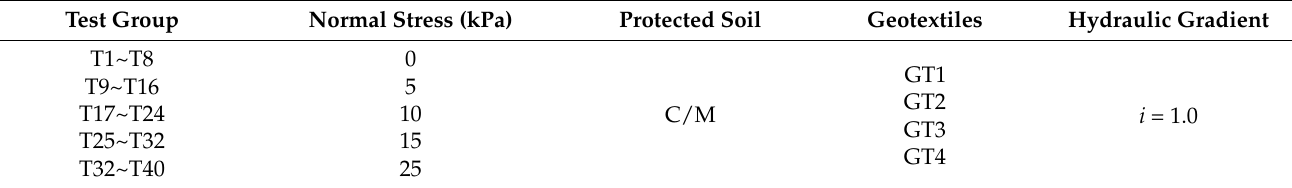
Table 4. Gradient ratio filtration test